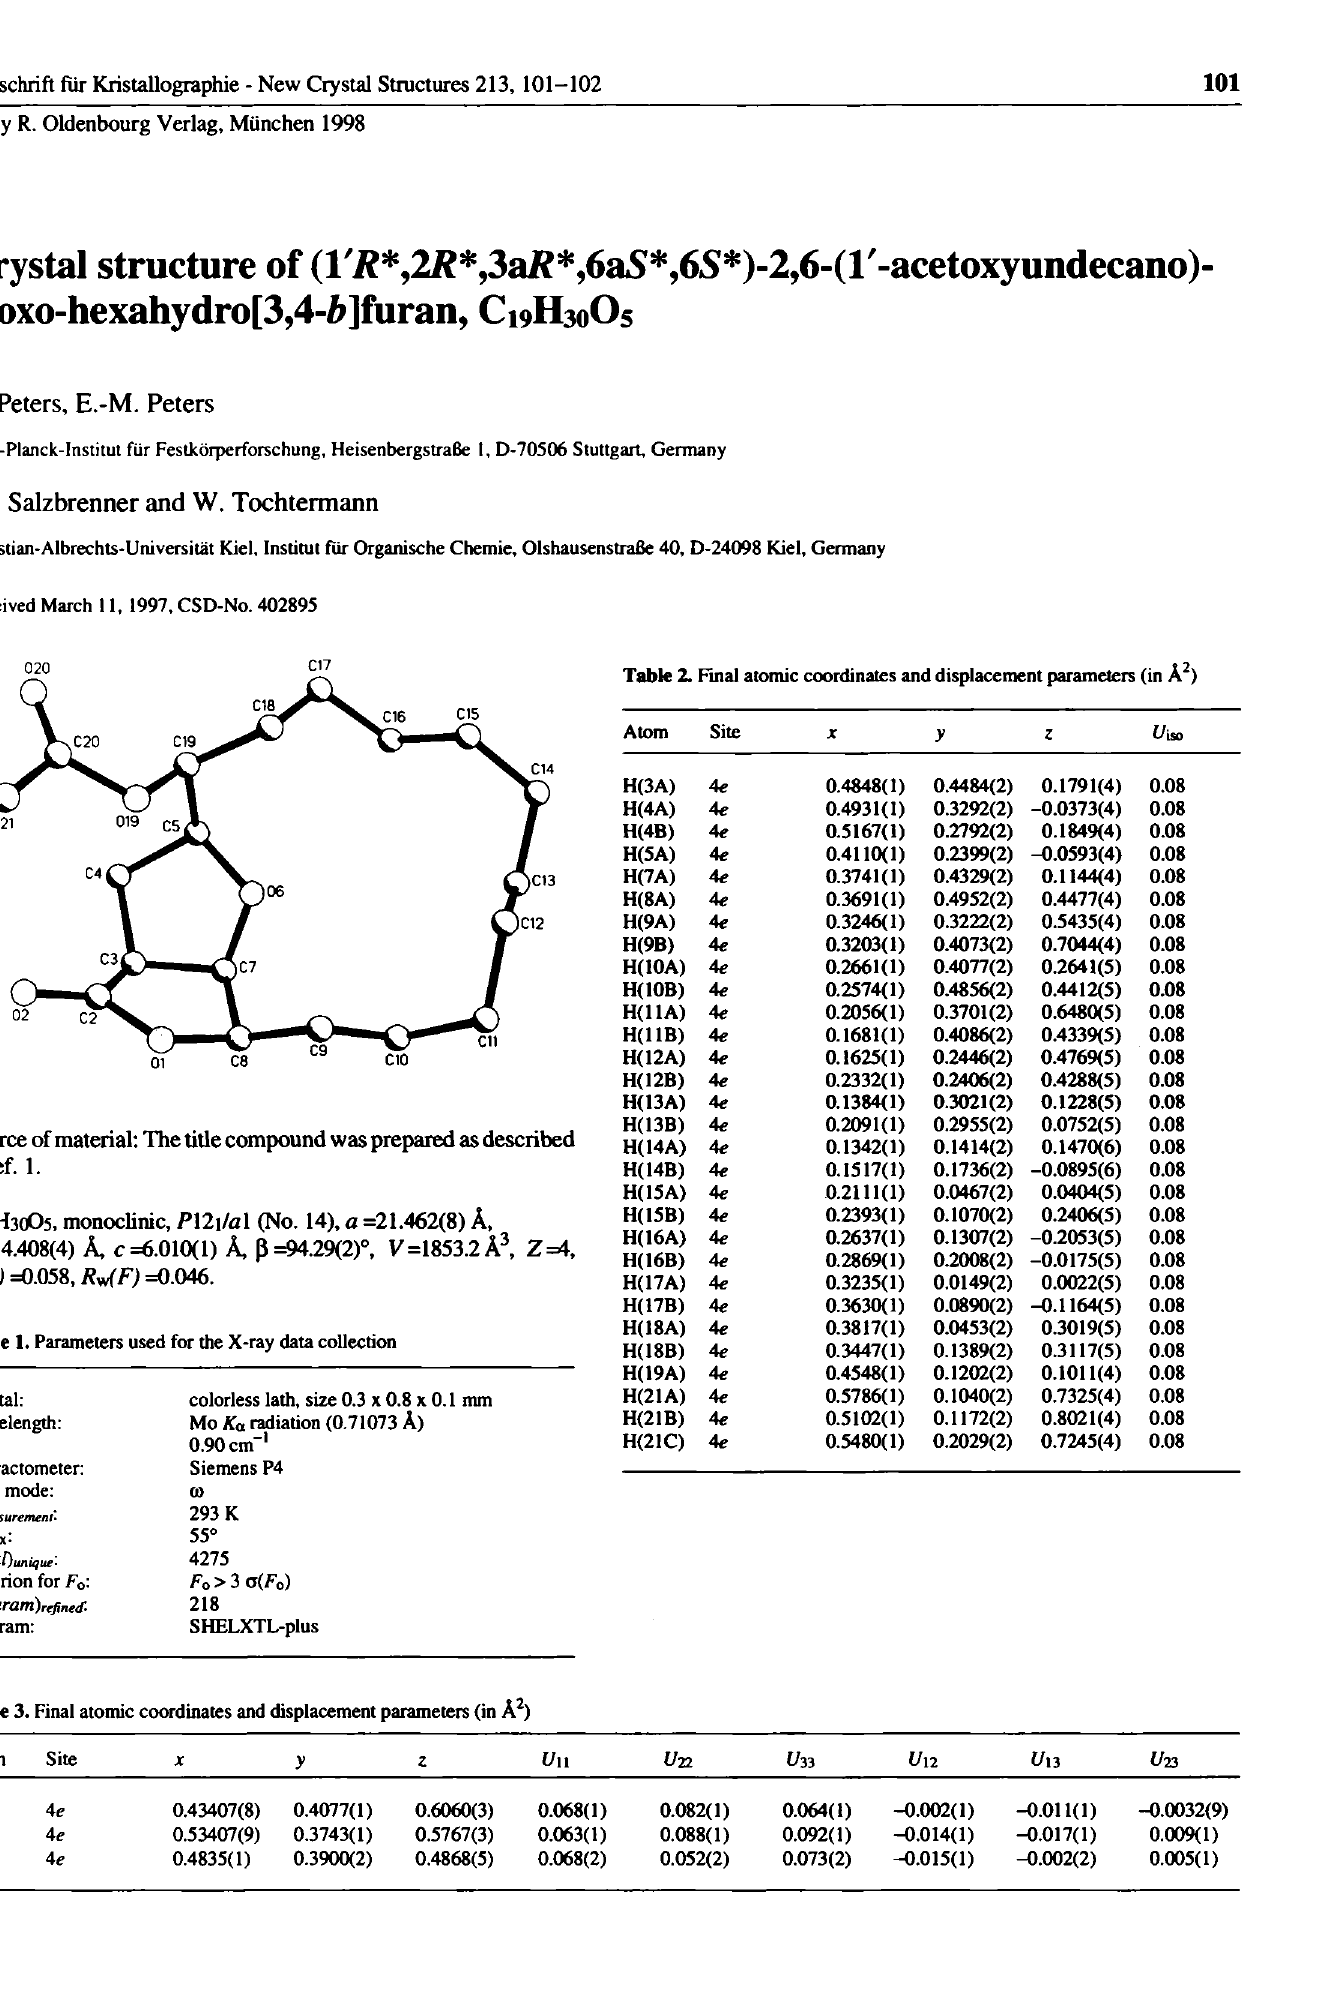
Table 3. Final atomic coordinates and displacement parameters (in